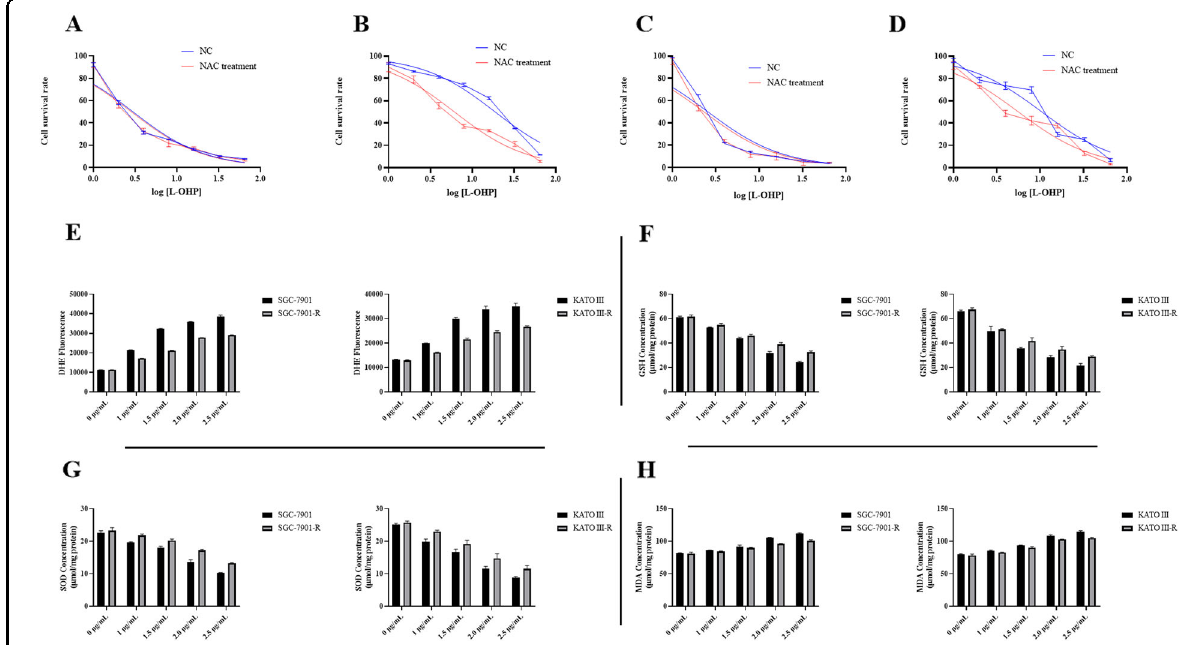
Fig. 1 Oxidative stress in oxaliplatin resistant gastric cancer cells. A CCK-8 test for SGC-7901 to evaluate the IC50 after treating with or without NAC. Two way ANOVA test, NC vs NAC: 1 μ g/ml L-OHP, t = 0.208, På 0.999; 2 μ g/ml L-OHP, t = 2.914, p = 0.033, 4 μ g/ml L-OHP, t = 1.249, P = 0.818; 8 μ g/ml L-OHP, t = 3.642, P = 0.004; 16 μ g/ml L-OHP, t = 0.936, P = 0.9521; 32 μ g/ml L-OHP, t = 0.312, På 0.999; 64 μ g/ml L-OHP, t = 1.041, P =